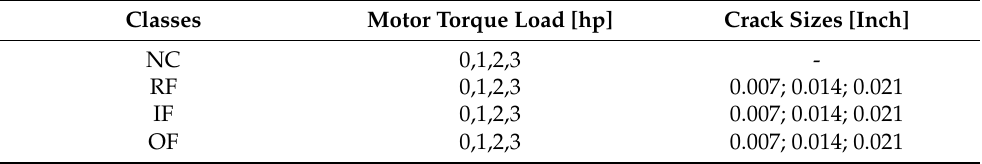
Table 2. The CWRUBD experimental